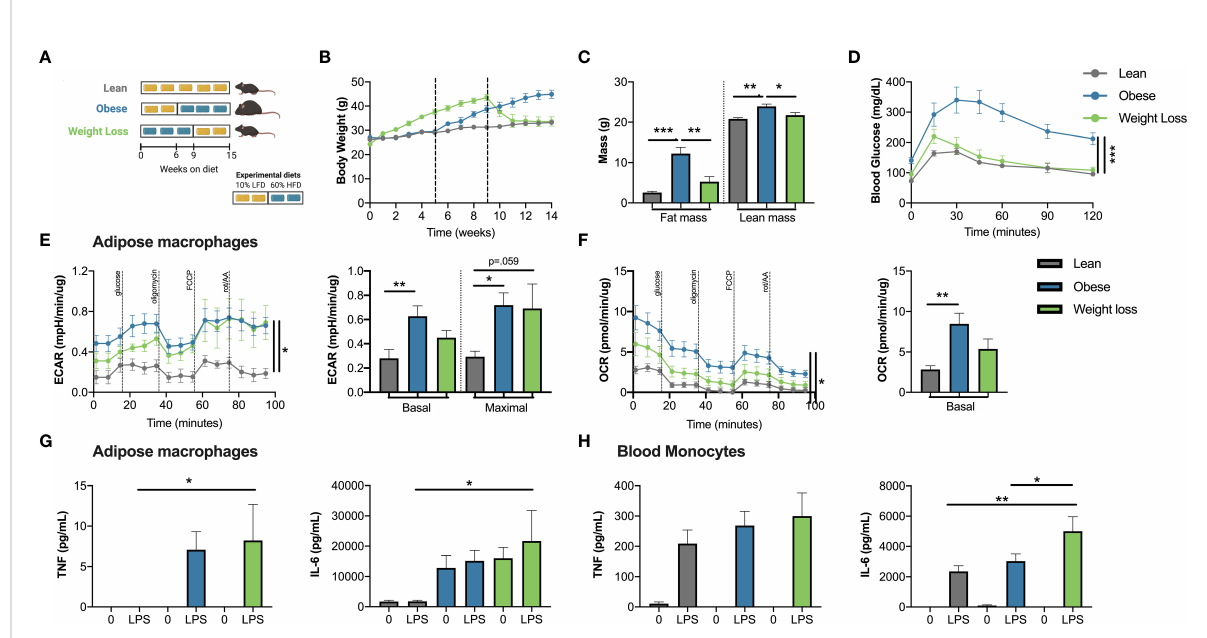
FIGURE 4 Weight loss doesn ’ t normalize the in fl ammatory response in adipose macrophages. (A) Weight loss in vivo schematic. (B) Body mass over time measured weekly with diet switch indicated by dashed lines. (C) Lean and fat mass measured by nuclear magnetic resonance. (D) Blood glucose during an intraperitoneal glucose tolerance test (1.5 g dextrose/kg lean mass) at 14 weeks. (E) Extracellular acidi fi cation rate (ECAR) and (F) oxygen consumption rate (OCR) of epididymal adipose macrophages selected by 2 hour adherence during modi fi ed mitochondrial stress test by Seahorse metabolic analyzer. (G) TNF and IL-6 production induced by 100 ng/mL LPS as measured by ELISA in epididymal adipose macrophages selected by 2-hour adherence and normalized to protein concentration. (H) TNF and IL-6 production induced by 100 ng/mL LPS as measured by ELISA in monocytes selected by 2-hour adherence and normalized to protein concentration. Data are means ± SEM of 6-8 mice, representative of 2 independent experiments. * p < 0.05, ** p < 0.01, *** p <